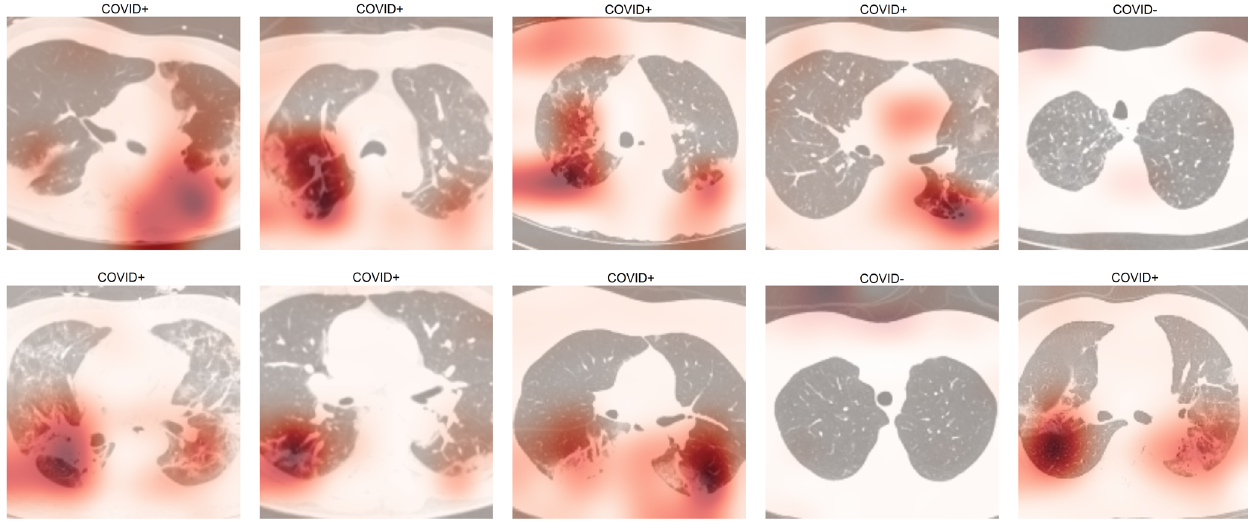
Fig. 8 Grad-CAM over CT scans of COVID19 + and COVID19- pneumonia patients. On top right, DCD correctly diagnosed the scan of a COVID19- patient with PNA who showed signs of ground glass opacity.